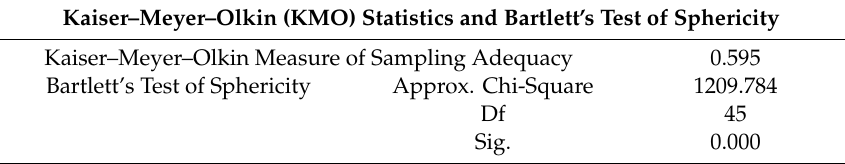
Table 4. Kaiser–Meyer–Olkin (KMO) statistics and Bartlett’s test of sphericity.